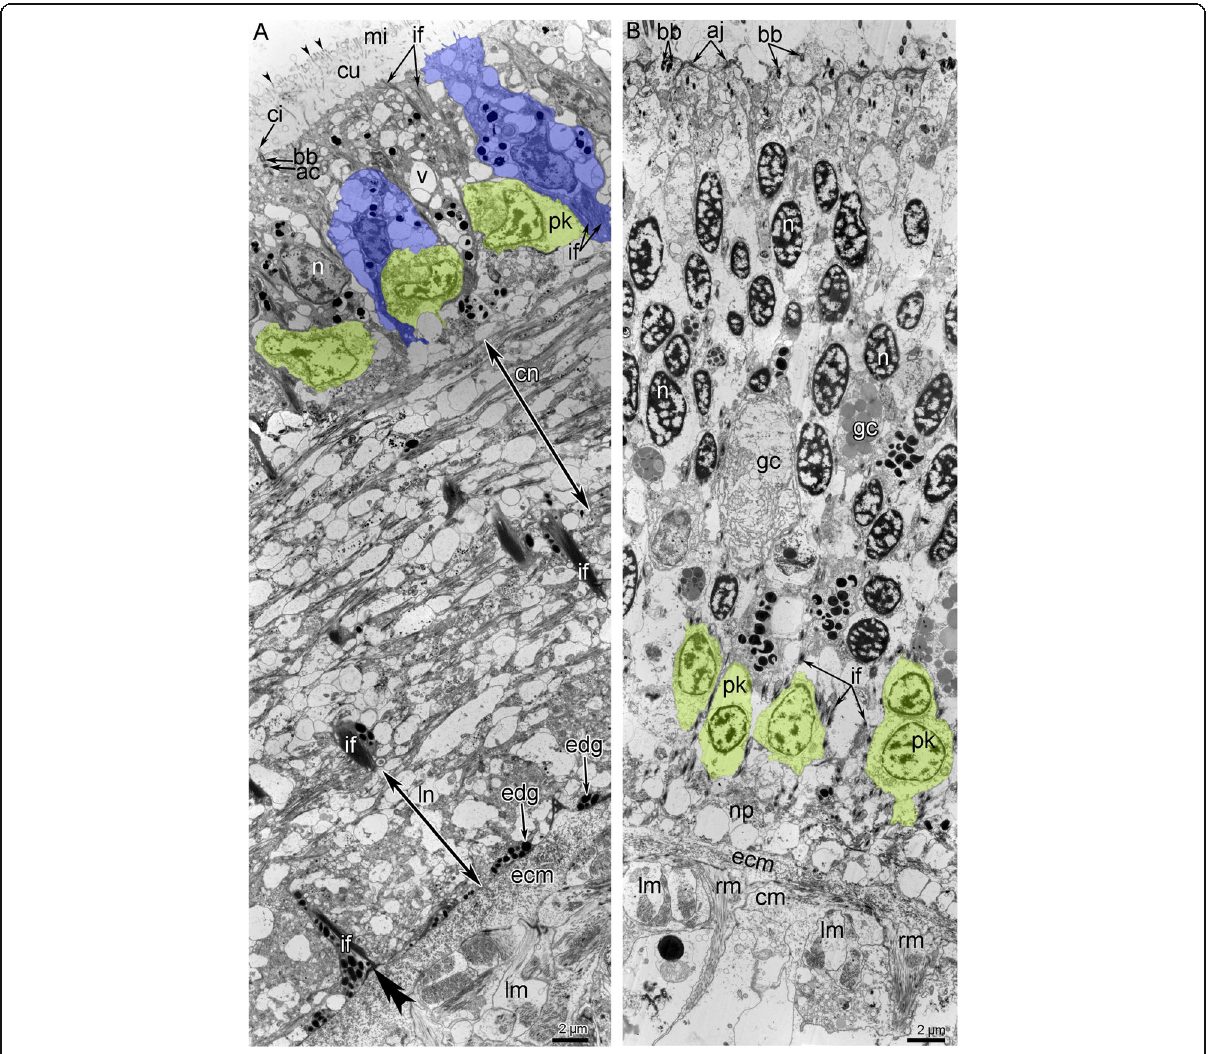
Fig. 11 Ultrastructure of head nerve elements in Owenia borealis . Ultra-thin transverse sections. A A portion of the outer ring of the anterior nerve center. B A portion of the circumoral nerve ring. Supportive cells (= radial glial cells) are shown in blue; perikarya are shown in yellow. Hemidesmosome is indicated by double arrowhead. Dense tips of microvilli are indicated by arrowheads. Abbreviations: ac – accessory